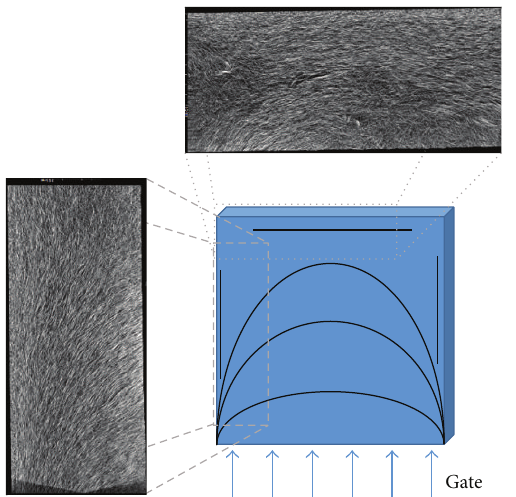
Figure 7: CT analysis of an injection molded plate of PP-LGF30.